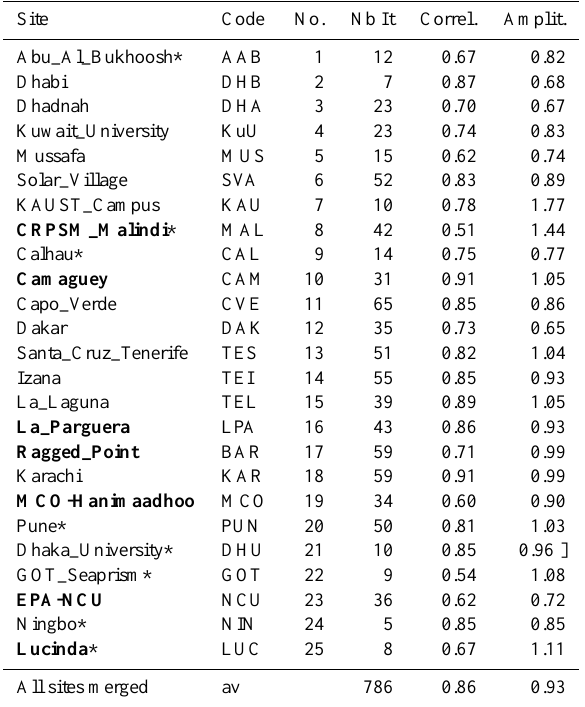
Table 2. Correlation between IASI AOD and 500nm coarse-mode AERONET AOD (column 5), and amplitude (normalized standard deviation of IASI) (last column), over oceanic regions. Each site is identified by its name (first column), its three-digit code (sec- ond column), and identification number (third column). The fourth column gives the number of items in the statistics (“Nb it”). The last line gives the overall statistics (all sites merged). An asterisk in the first column indicates that the AERONET coarse-mode AOD data at this site are “Level 1.5” instead of “Level 2.0” (see text). Bold names correspond to stations with weak mean IASI AOD (all- period average less than 0.08).